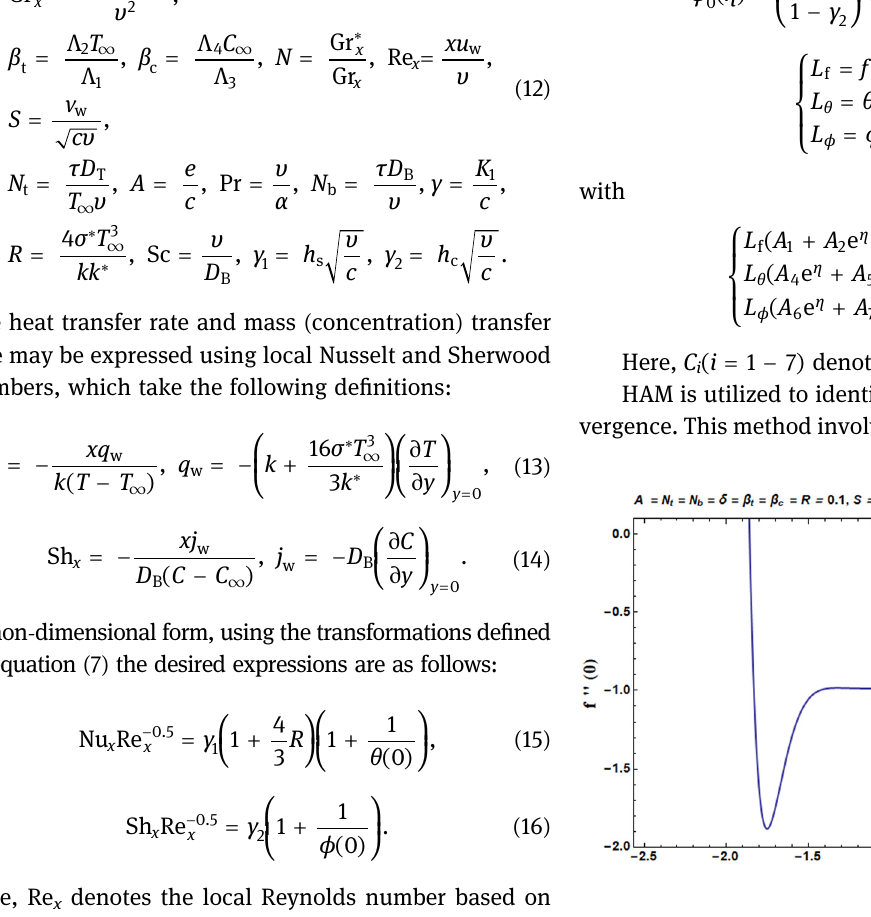
Figure 2: H curve stimulus for f ″ 0 ( )